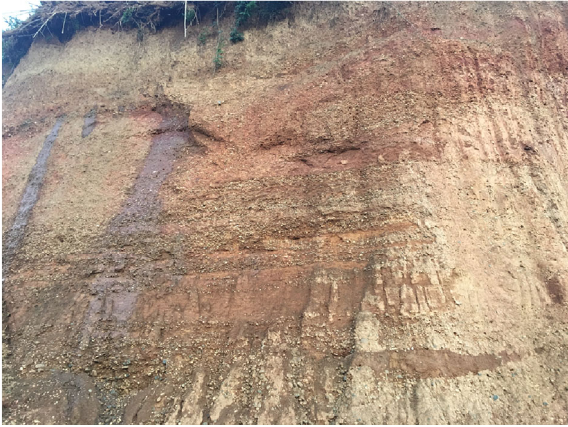
Figure 2: Typical pro fi le of clay gravel